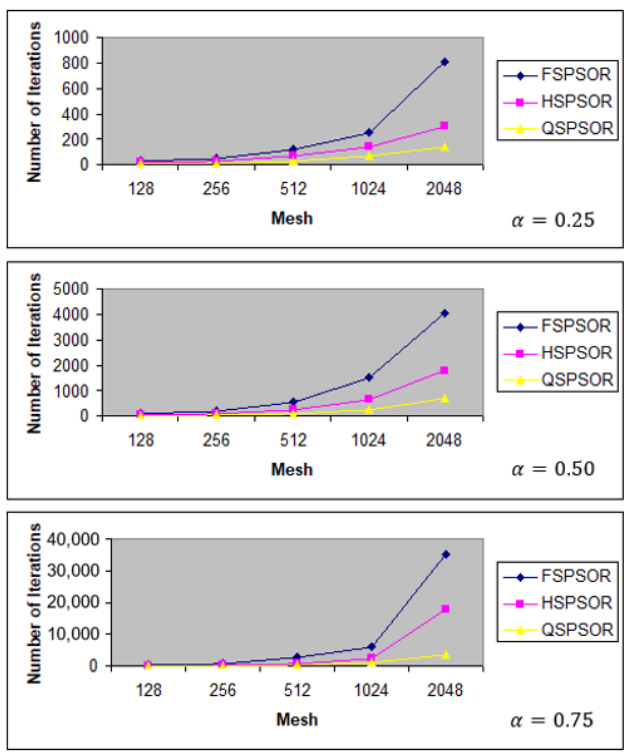
Figure 1. Graphs of performance of FSPSOR, HSPSOR, and QSPSOR methods to solve Example 1, showing mesh sizes versus number of iterations for three different fractional orders.